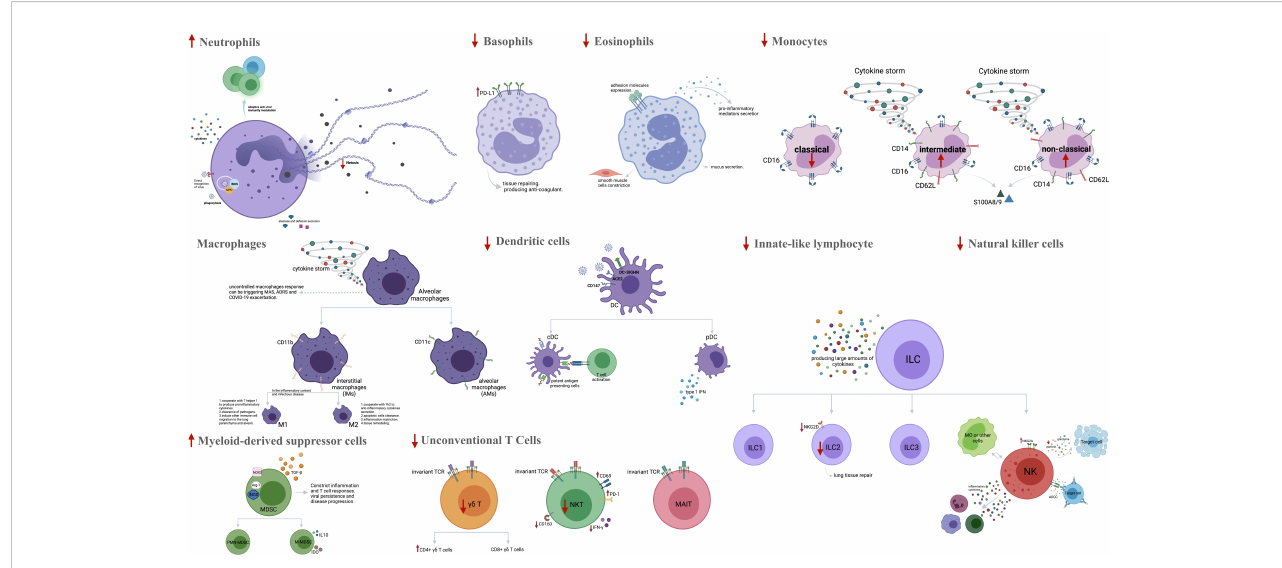
FIGURE 1 The frequency and function of innate immune cells in severe COVID-19. SARS-CoV-2 infects cells that present the surface receptor ACE2. It is recognized by tissue-resident immune cells in the lungs, which provoke a local immune response. More innate immune cells are recruited from the blood by chemokines and complement activation products. The amounts of neutrophils, CD16 + monocytes, M1 macrophages and MDSCs are bigger in severe COVID-19 patients, while the percentages of basophils, eosinophils, M2 macrophages, classical monocytes, DCs, ILCs, NK cells and unconventional T cells are reduced. Activated neutrophils can amplify in fl ammation by secretion of pro-in fl ammatory cytokines, MPO, elastase and defensins. They can also promote NET formation and Th17 cell differentiation. Activated basophils and eosinophils appear to predispose the development of ARDS by releasing in fl ammatory and vasoactive substances. Peripheral CD16 + monocytes and M1 macrophages are involved in a hyper-in fl ammatory response and cytokine storm during the in fl ammatory phase in severe COVID-19. Signi fi cant decrease in viral sensing and IFN signaling as well as suppressed antigen presentation by both pDC and cDC have been reported in severe COVID-19. Aberrant or ineffective responses of ILCs (ILC1, ILC2, ILC3 and NK cells), MDSCs and unconventional T cells (MAIT cells, gd T cells) also have role in promoting in fl ammation in severe COVID-19. ACE2, Angiotensin-converting enzyme 2; MDSCs, Myeloid-derived suppressor cells; DC, Dendritic cell; ILCs, Innate-like lymphocyte; NK cell, Natural killer cell; MPO, Myeloperoxidase; NET, Neutrophil extracellular trap; Th, T helper; ARDS, Acute respiratory distress syndrome; MAS, Macrophage activation syndrome; PD-L1, Programmed cell death ligand 1; IFN: Interferon; cDC, Classical DC; pDC, Plasmacytoid DCiNOS, Inducible nitric oxide synthase; PMN-MDSCs, Polymorphonuclear-MDSCs; M-MDSCs, Monocytic-MDSCs; ADCC, antibody-dependent cellular cytotoxicity; NKG2A, NK cell lectin-like receptor subfamily C member 1. Figure was created by BioRender (Toronto, ON,